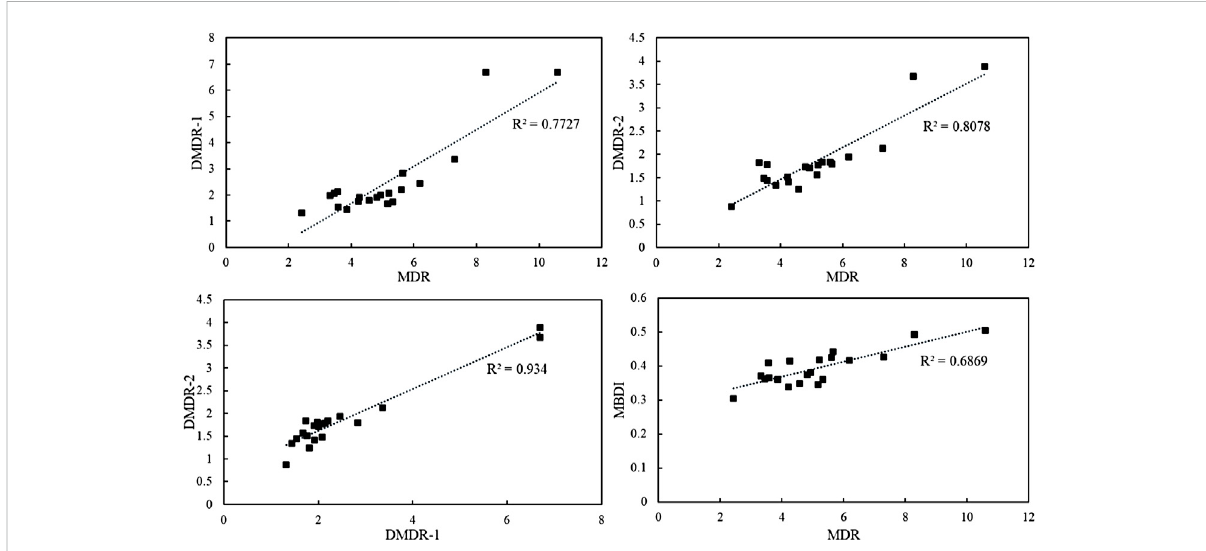
FIGURE 13 Correlation diagrams of maturity parameters of alkyl dibenzothiophenes in crude oil from the East Fukang Sag.